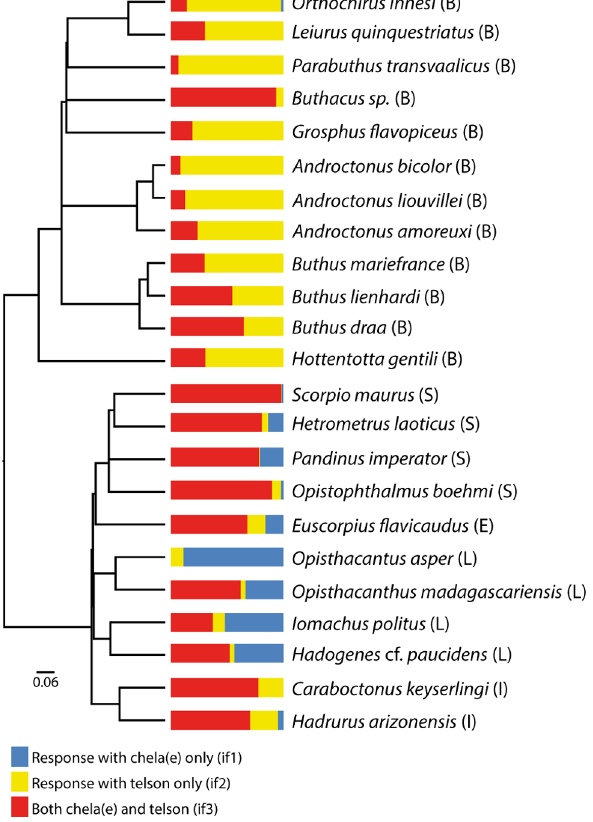
Figure 4. Ultrametric phylogram with branch lengths based on 12S, 16S and CO1 sequences. Colored bars showing proportions of behavioral responses, excluding non-responses, are placed at the tips.